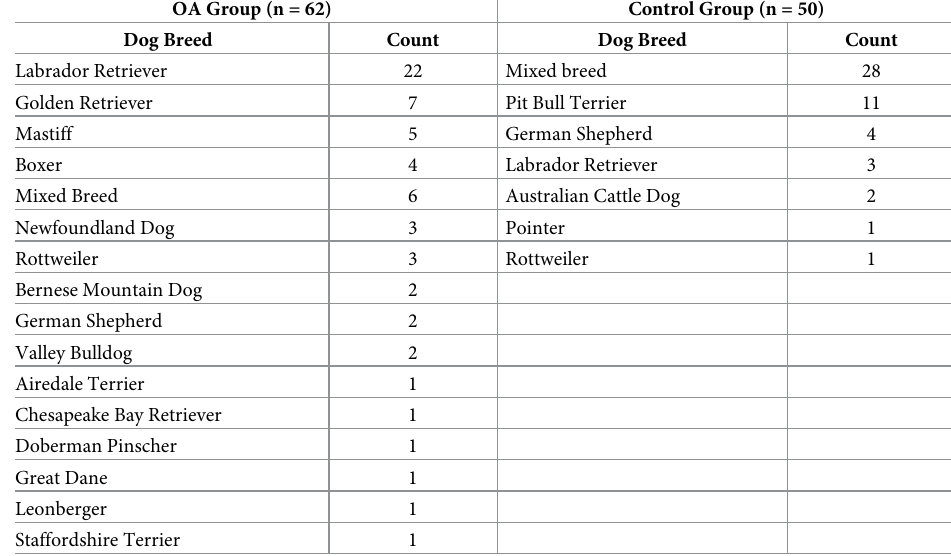
Table 1. Frequency of dog breeds. OA Group (n =